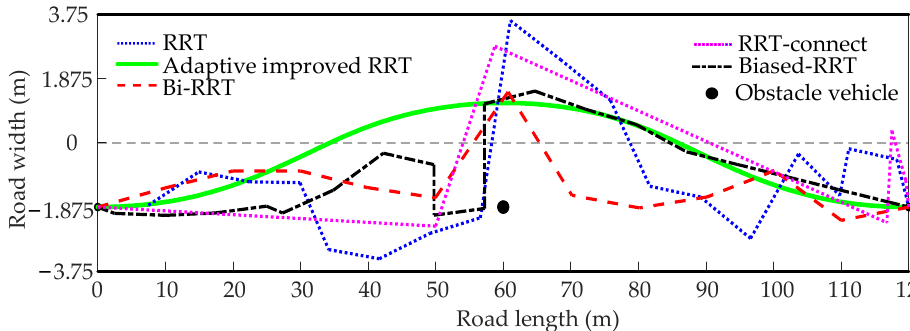
Figure 9. Performance contrast in straight road environment.